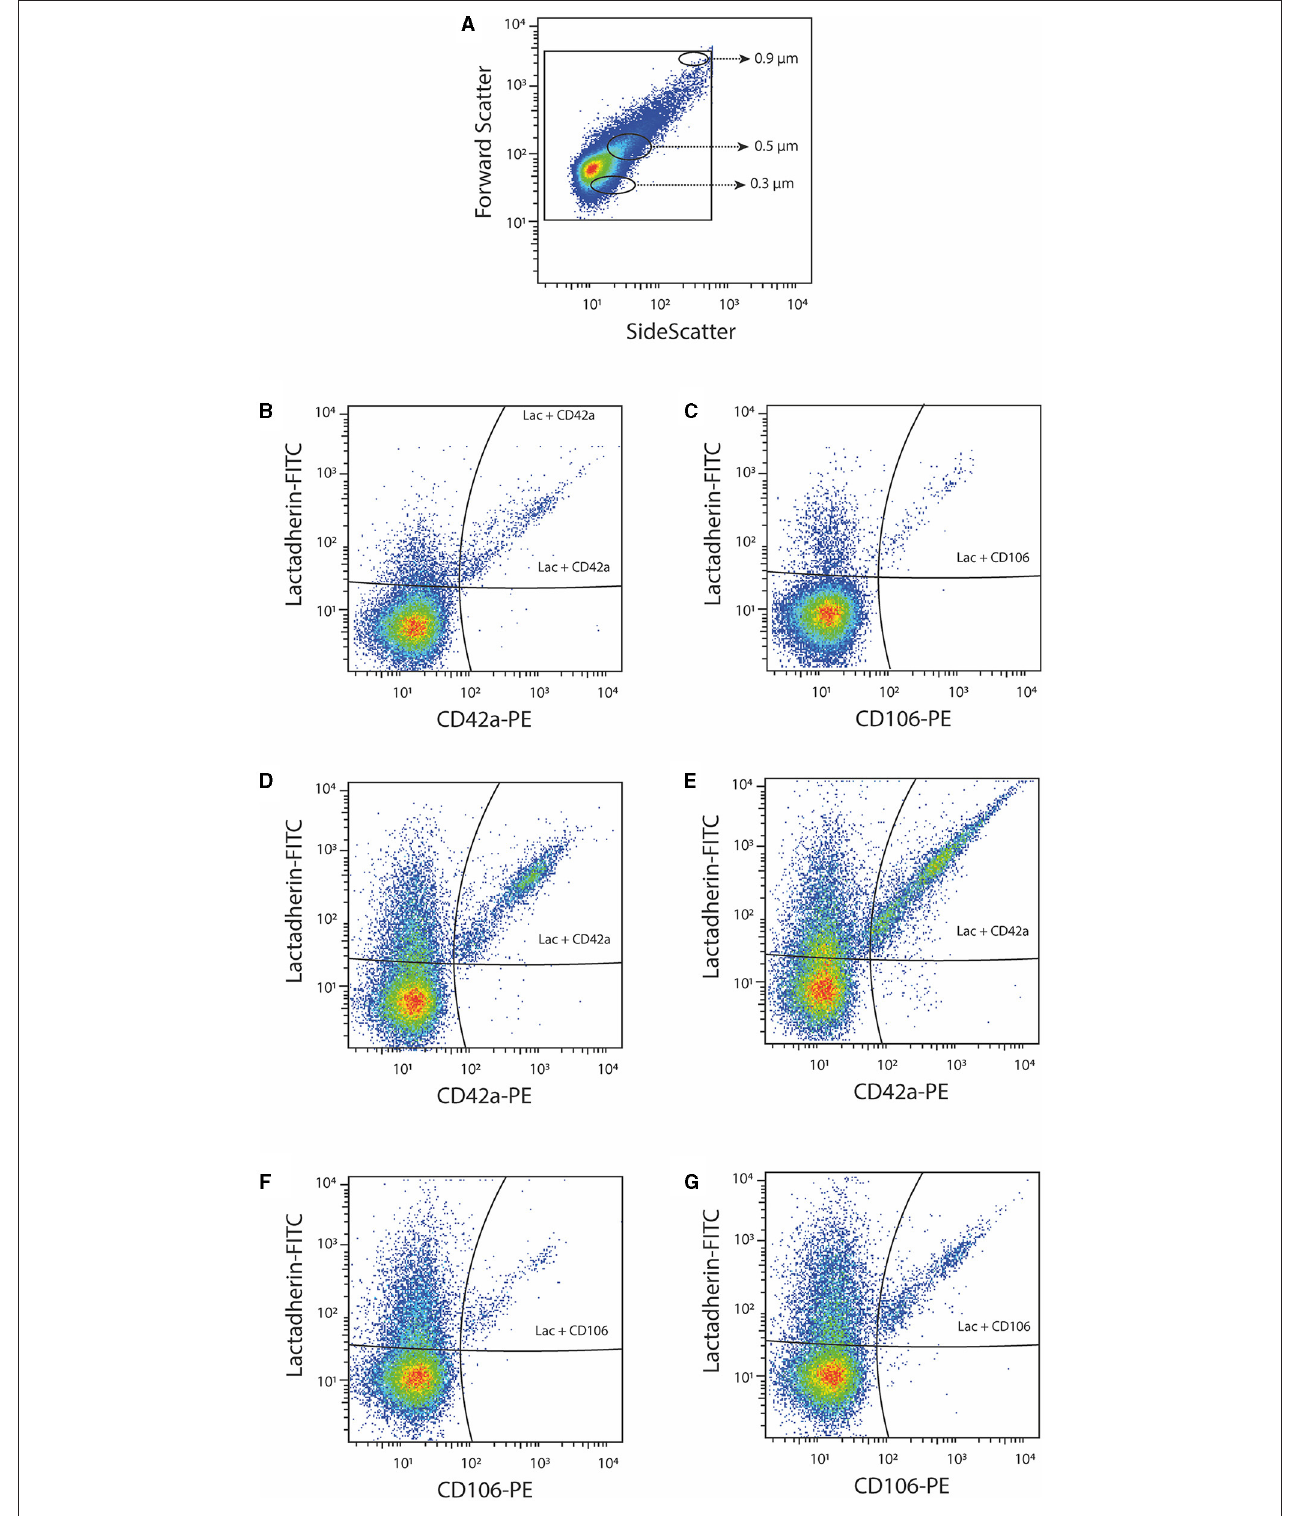
FIGURE 1 | Representative dot-plots of platelet-derived (CD42a + ) and VCAM-1 + (CD106 + ) EVs. (A) EV gating strategy based on beads with diameter 0.3, 0.5, and 0.9 µ m; (B,C) platelet-derived (CD42a + ) EVs and VCAM-1 + (CD106 + ) EVs in a healthy pregnant woman; (D,E) platelet-derived (CD42a + ) EVs in a patient with pre-eclampsia before and after delivery; (F,G) VCAM-1 + (CD106 + ) EVs in a patient with pre-eclampsia before and after delivery.